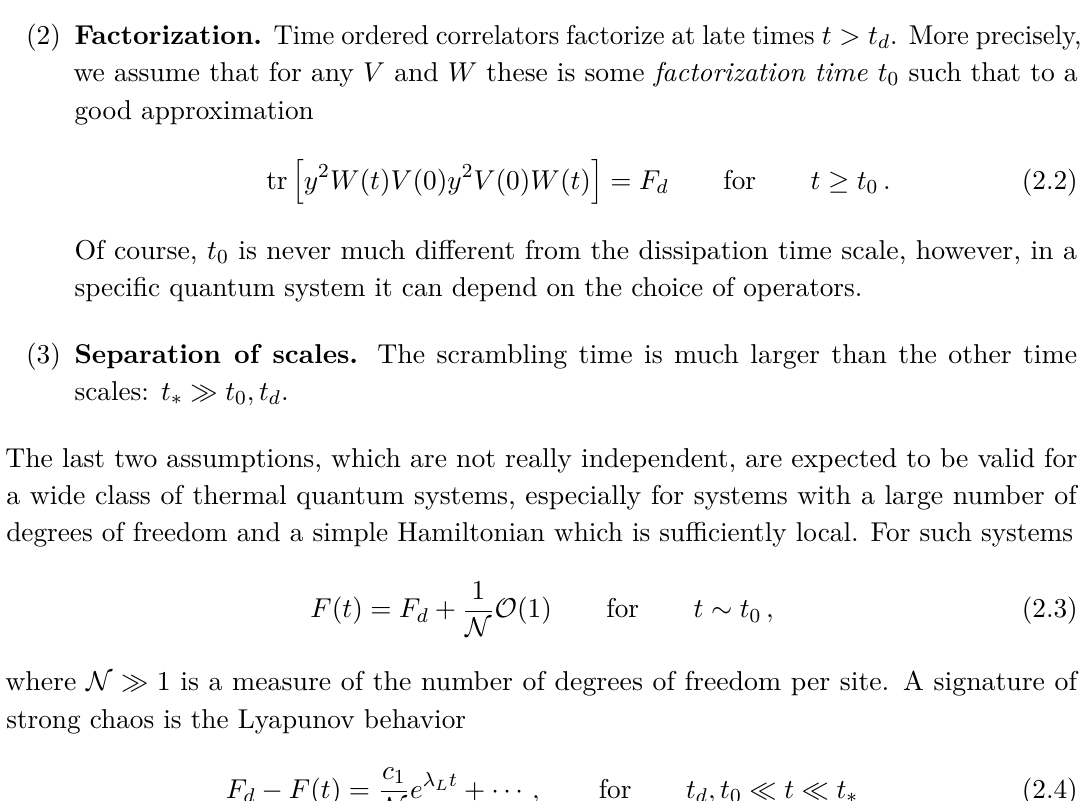
= dissipation time ∼ β , t = factorization time, and d 0